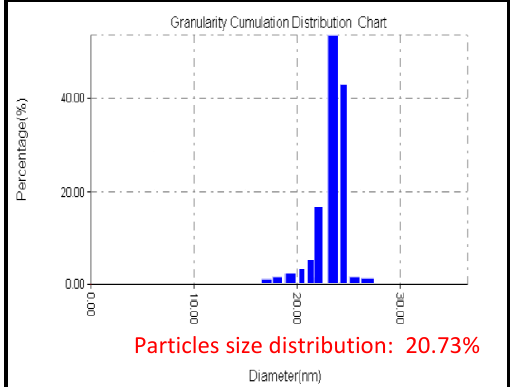
Figure 23. AFM 3D image of etoposide-loaded gold nanoparticles F1.